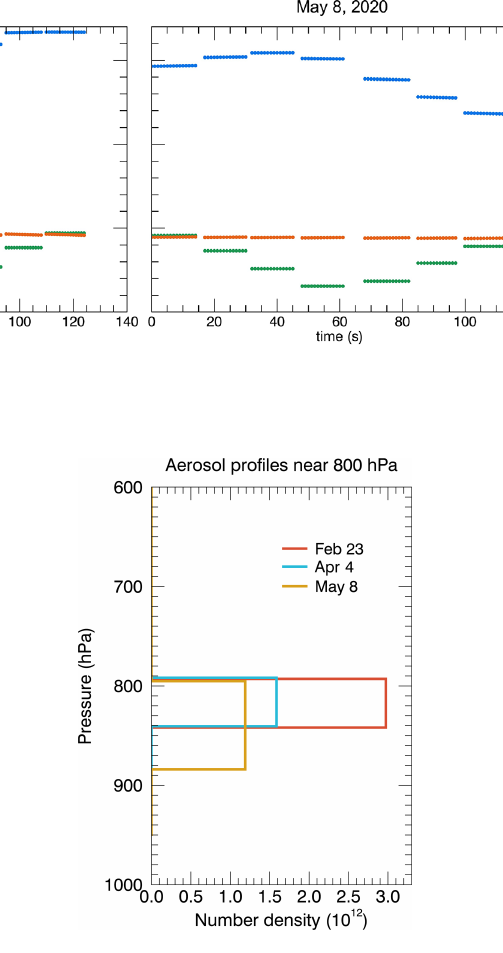
Figure 12. Profiles illustrating aerosol layer shape used for the three simulated SAMs. This example shows dust layers whose tops are placed at the native CALIOP pressure level closest to